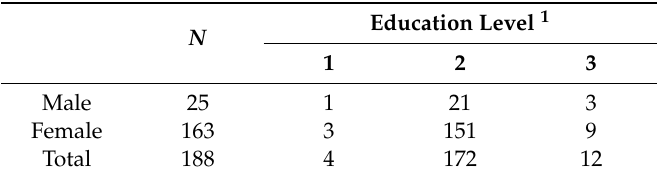
Table 1. Education levels of males and